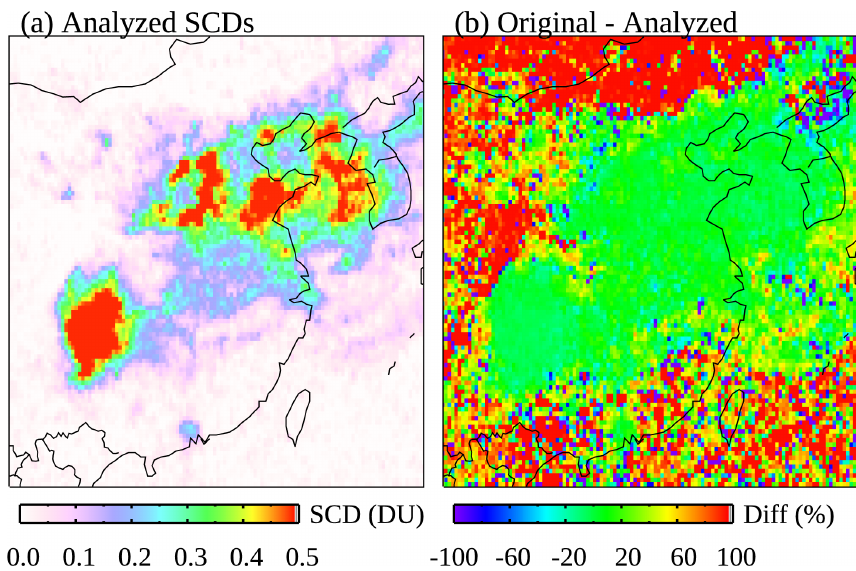
Figure 6. (a) The NN-analyzed SO 2 SCDs and (b) their relative differences from the original SCDs over eastern China for March 2005.